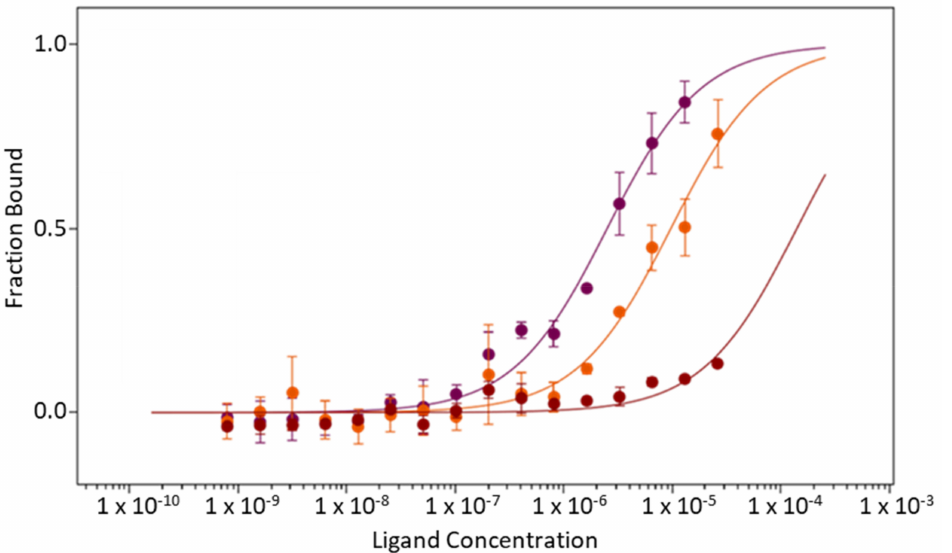
Figure 8. MST binding curves of PD-1 to NT650/PD-L1 at pH 6.2 (purple circles and line) and in presence of 50 µ M VIS1201 (orange circles and line), 100 µ M VIS1201 (red circles and